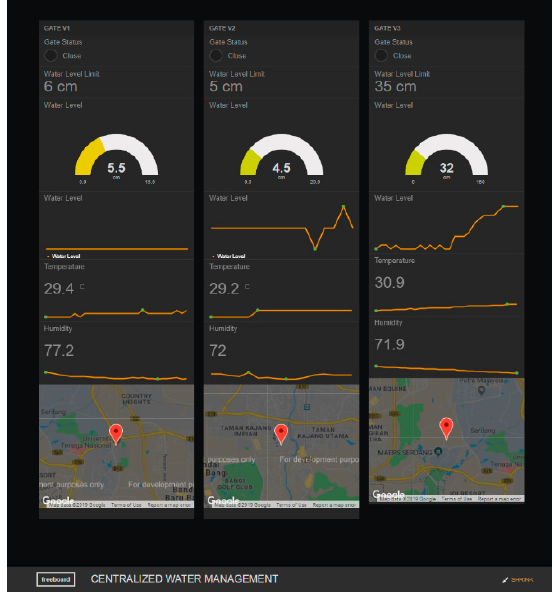
Figure 21. 2 / 3 of data completion from the IoT Client (Gate V1 stop updating). Figure 21. 2/3 of data completion from the IoT Client (Gate V1 stop updating).